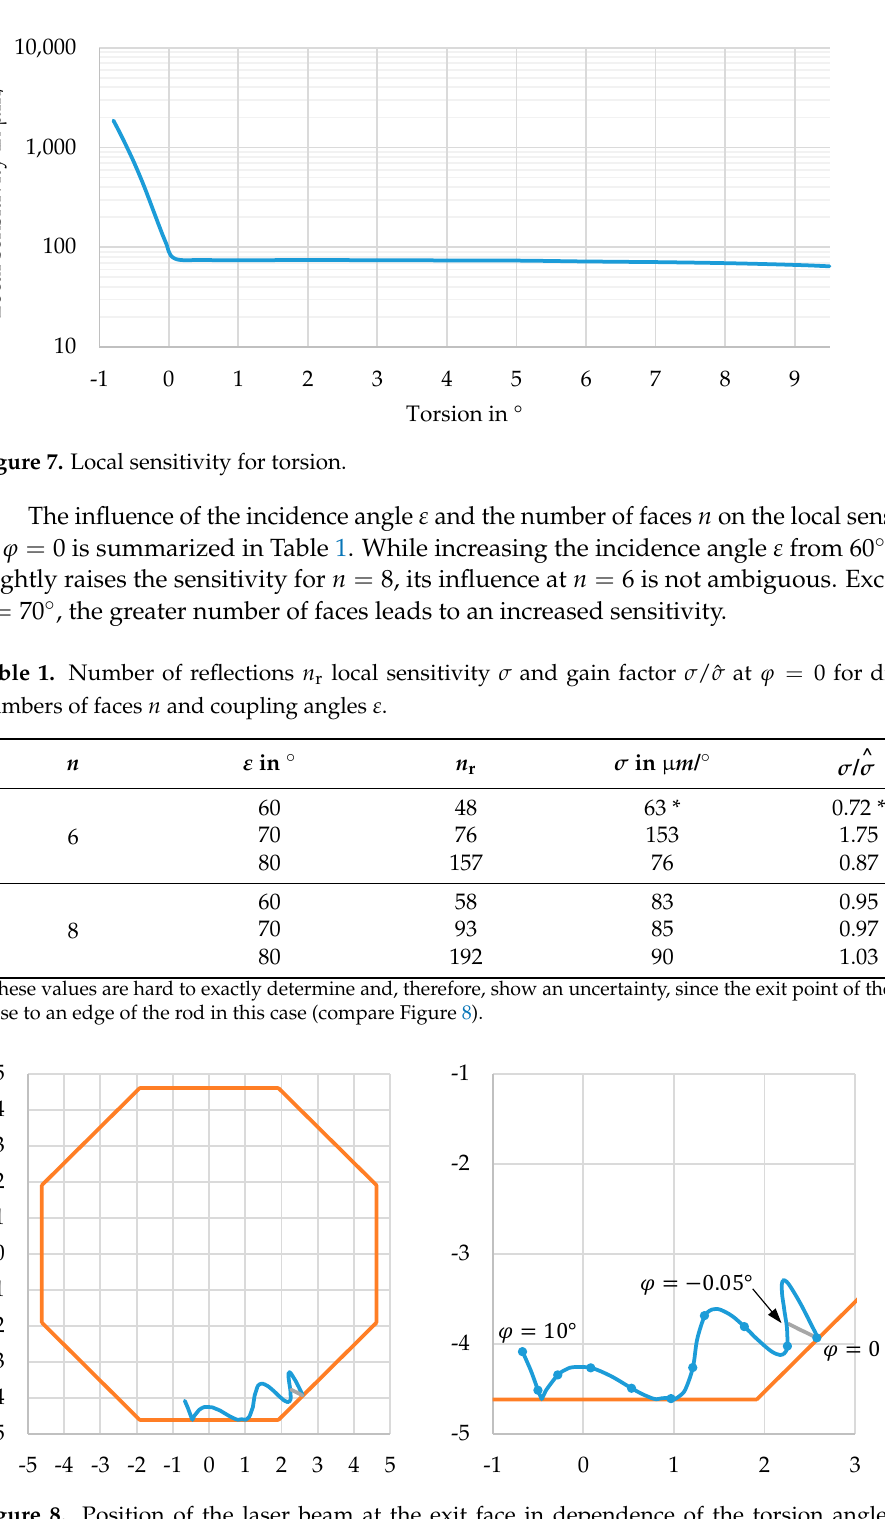
Figure 8. Position of the laser beam at the exit face in dependence of the torsion angle. Blue: 10° ≥ 𝜑 ≥ 0 , grey: 0 ≥ 𝜑 ≥ −0.05° , orange: shape of the exit face. Dots in enlarged diagram for each full degree of 𝜑 . Dimensions are in mm .